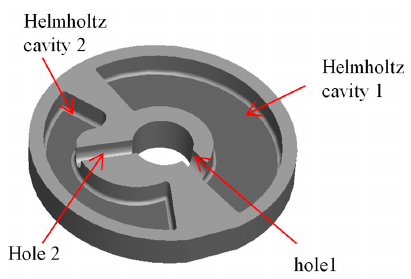
Figure 19. Helmholtz protector geometry.